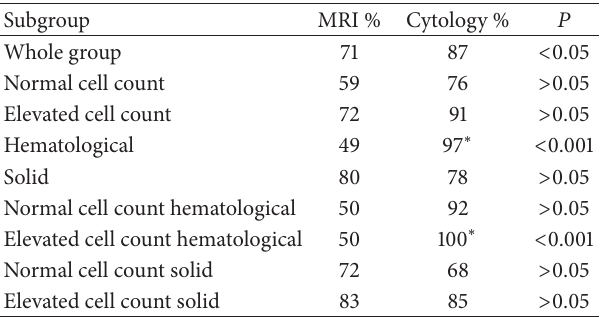
Table 1: Sensitivity for the detection of neoplastic